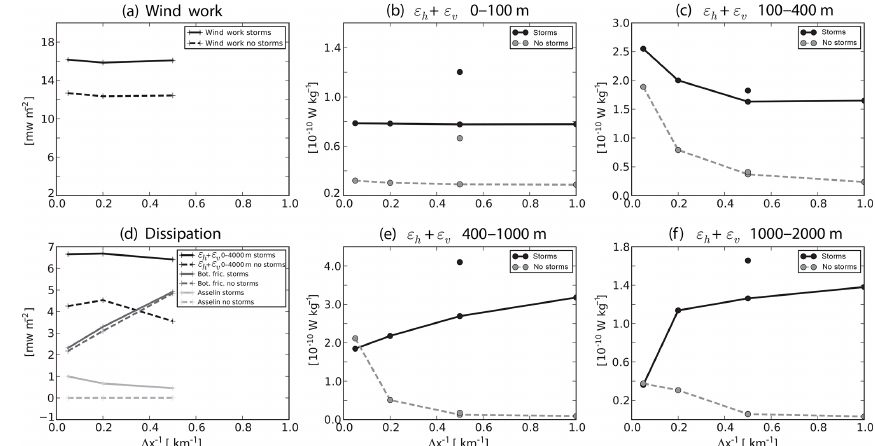
Figure 14. Kinetic energy dissipation ( ε ) and wind work as a function of model resolution, in experiments with (continuous lines) and without storms (dashed lines): (a) wind work and energy dissipation integrated from surface to bottom (mWm − 2 ) , (d) energy dissipation integrated from surface to bottom (decomposed into contributions from ε , bottom friction and Asselin time filter; mWm − 2 ) and total dissipation ε (Wkg − 1 ) averaged in the depth ranges 0–100m (b) , 100–400m (c) , 400–1000m (d) and 1000–2000m (e) . Values are computed using 5-day snapshots of the entire domain for a 2-year period as in Fig. 9. Isolated dots represent ε for the 2km experiment with 320 vertical levels. Wind work (a) and energy dissipation contributions (d) have only been computed for the 20, 5 and 2km